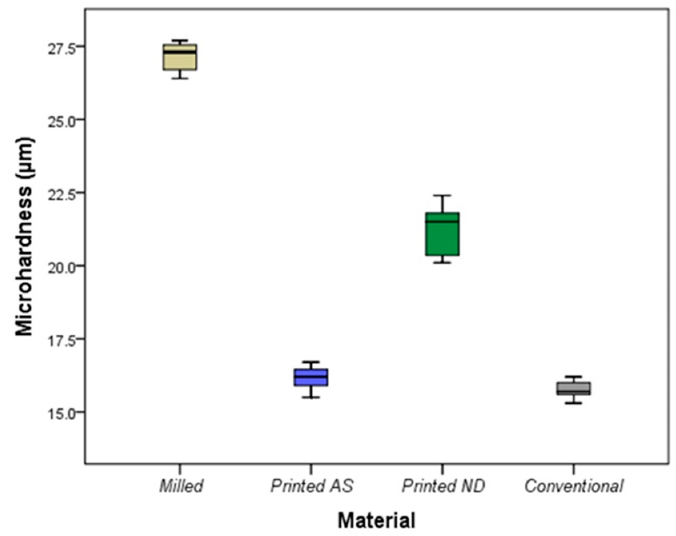
Figure 4. Microhardness of the studied materials. Middle line represents the median, box outline represents the interquartile range (25th–75th percentiles), and the two whiskers represent the range (minimum–maximum).